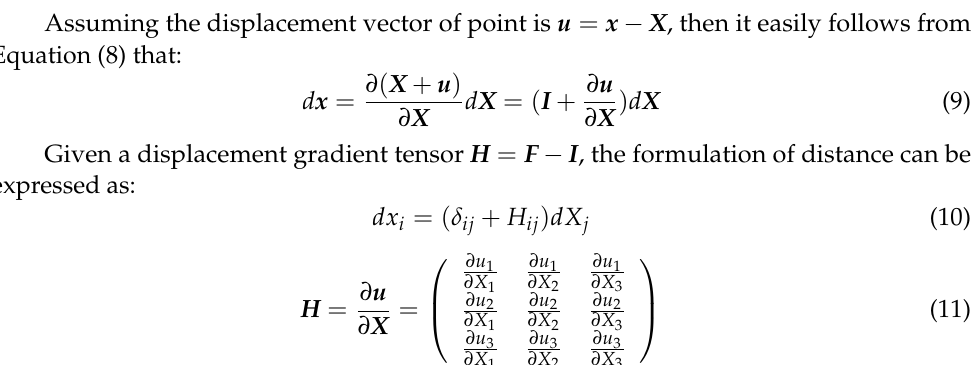
d + X X . The distance vector between two adjacent points is